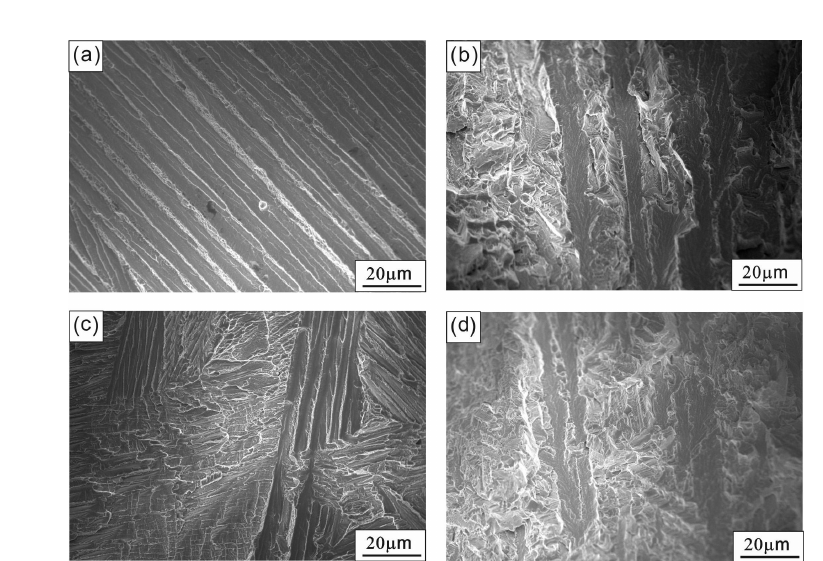
Figure 6. SEM fractographs of Ti15Sn x Cu alloys: (a) AS Ti15Sn, (b) HT Ti15Sn, (c) AS Ti15Sn2Cu and (d) HT Ti15Sn2Cu.